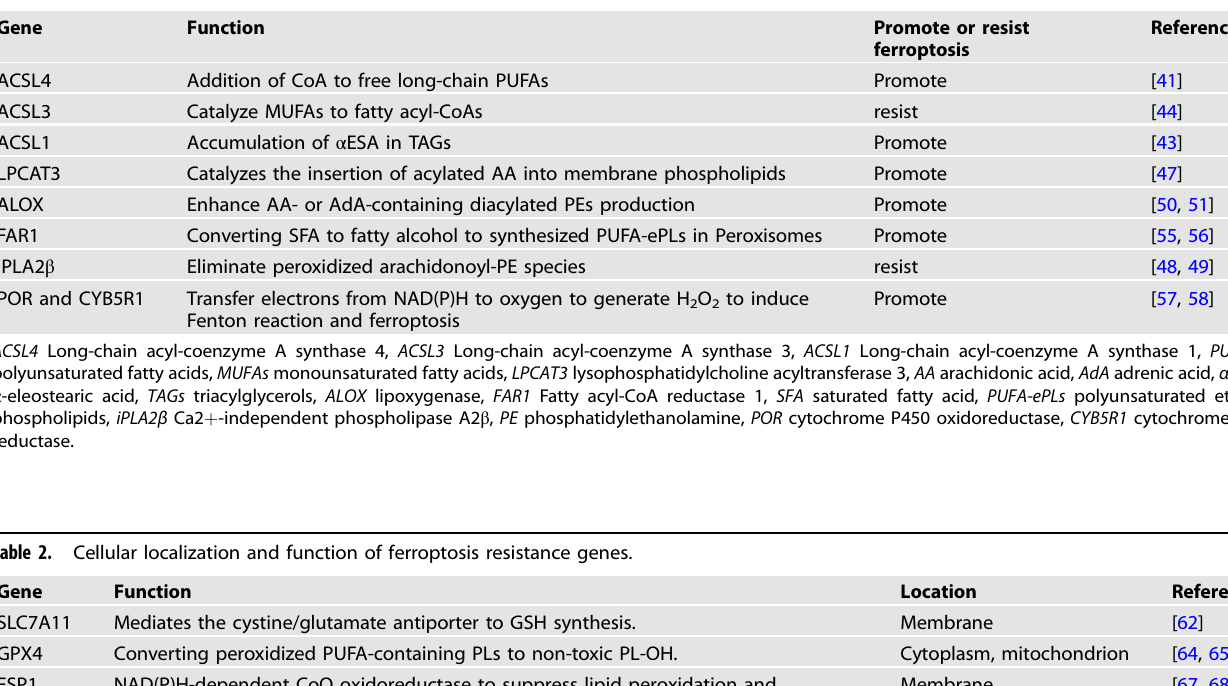
Membrane [67, 68] mitochondrion [72] Cytoplasm [74]